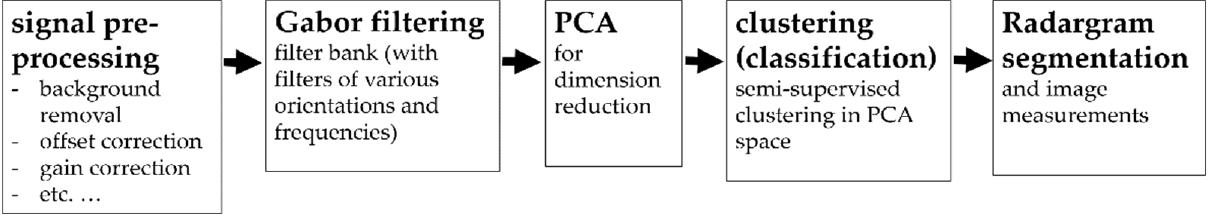
Figure 3. Overview of the proposed image processing chain for radargram segmentation.